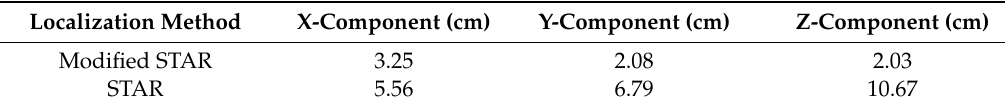
Table 3. The Computation Times of the Two Methods.